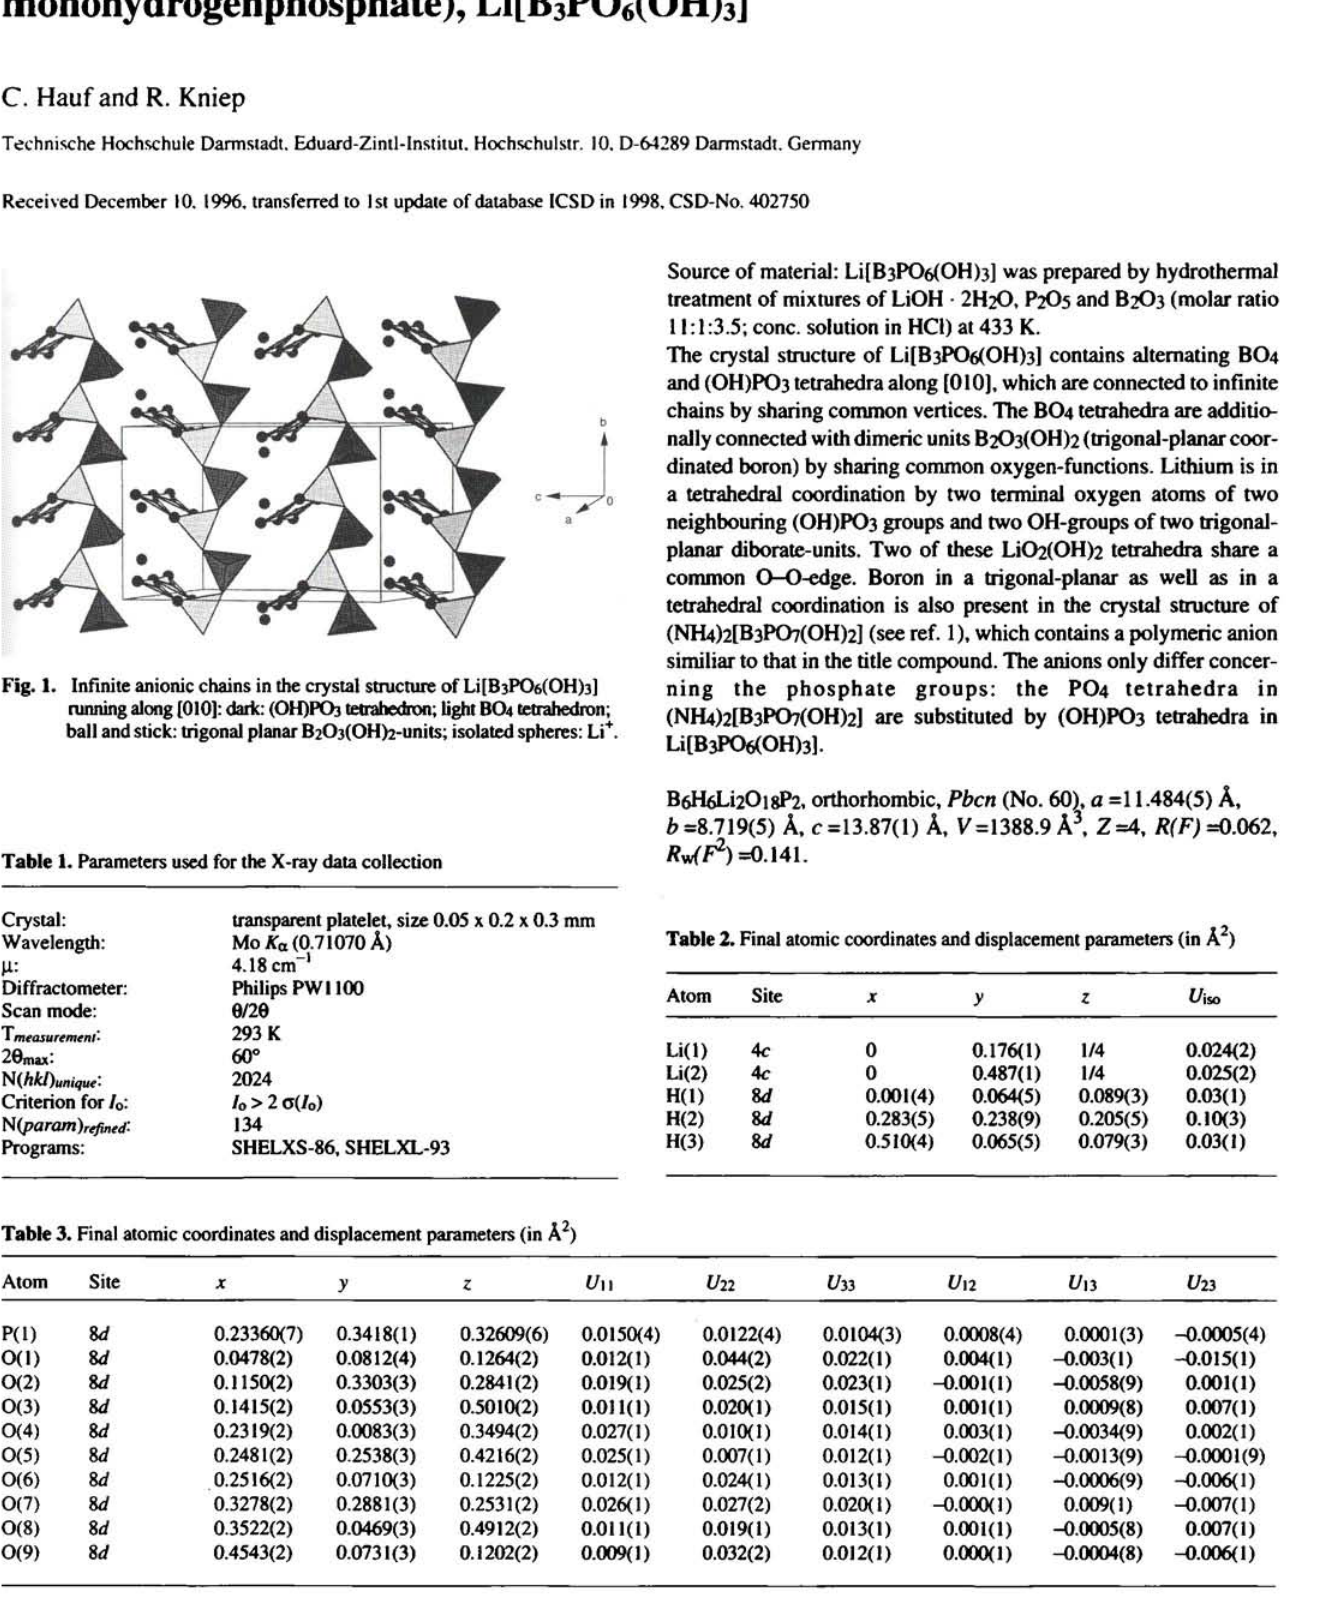
Table 2. Final atomic coordinates and displacement parameters (in A 2 )